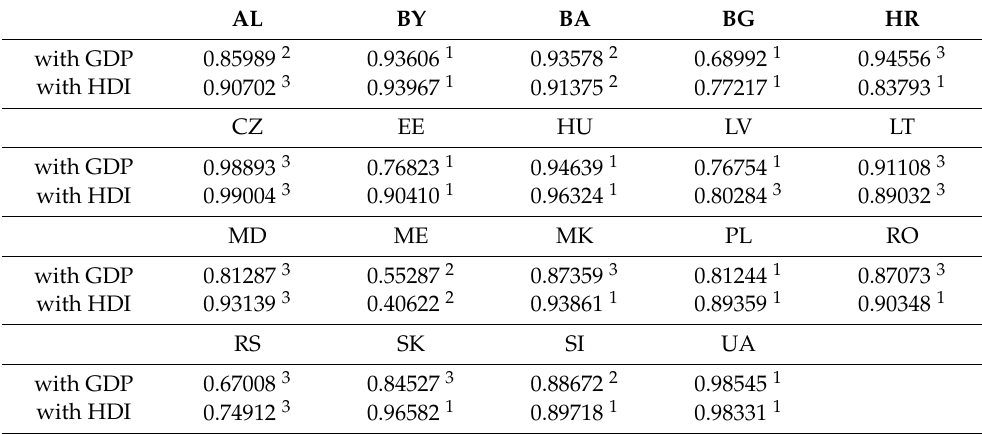
Table 10. Comparison of the models for GDP per capita and the HDI index due to the R 2 . AL BY BA BG with GDP